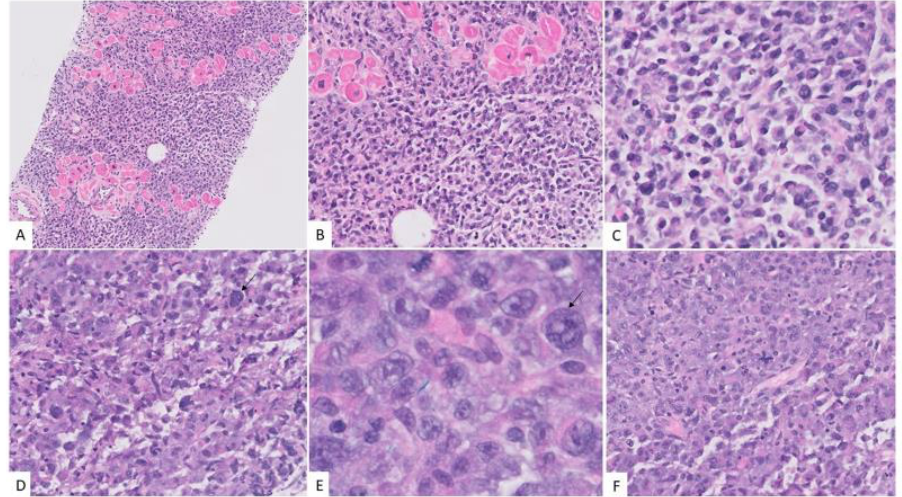
Figure 4. Morphologic features of anaplastic myeloma. The neoplastic cells infiltrated the cardiac muscles. ( A ) Hematoxylin and eosin stain, X40, while some areas had more plasmacytoid cells. ( B , C ) Hematoxylin and eosin stain, X100, X400 there were other areas with marked pleomorphism (black arrows) and presence of binucleate cells. ( D , E ) Hematoxylin and eosin stain, X400 and 1000X) with basophilic cytoplasm and frequent mitosis. ( F ) Hematoxylin and eosin stain, X400. Neoplastic cells were negative for all immunohistochemical stains in the initial panel which included CD3, CD20, CD138, and AE1/3. Lambda immunoglobulin light chain re- striction was positive in the neoplastic cells . An extended panel was performed which